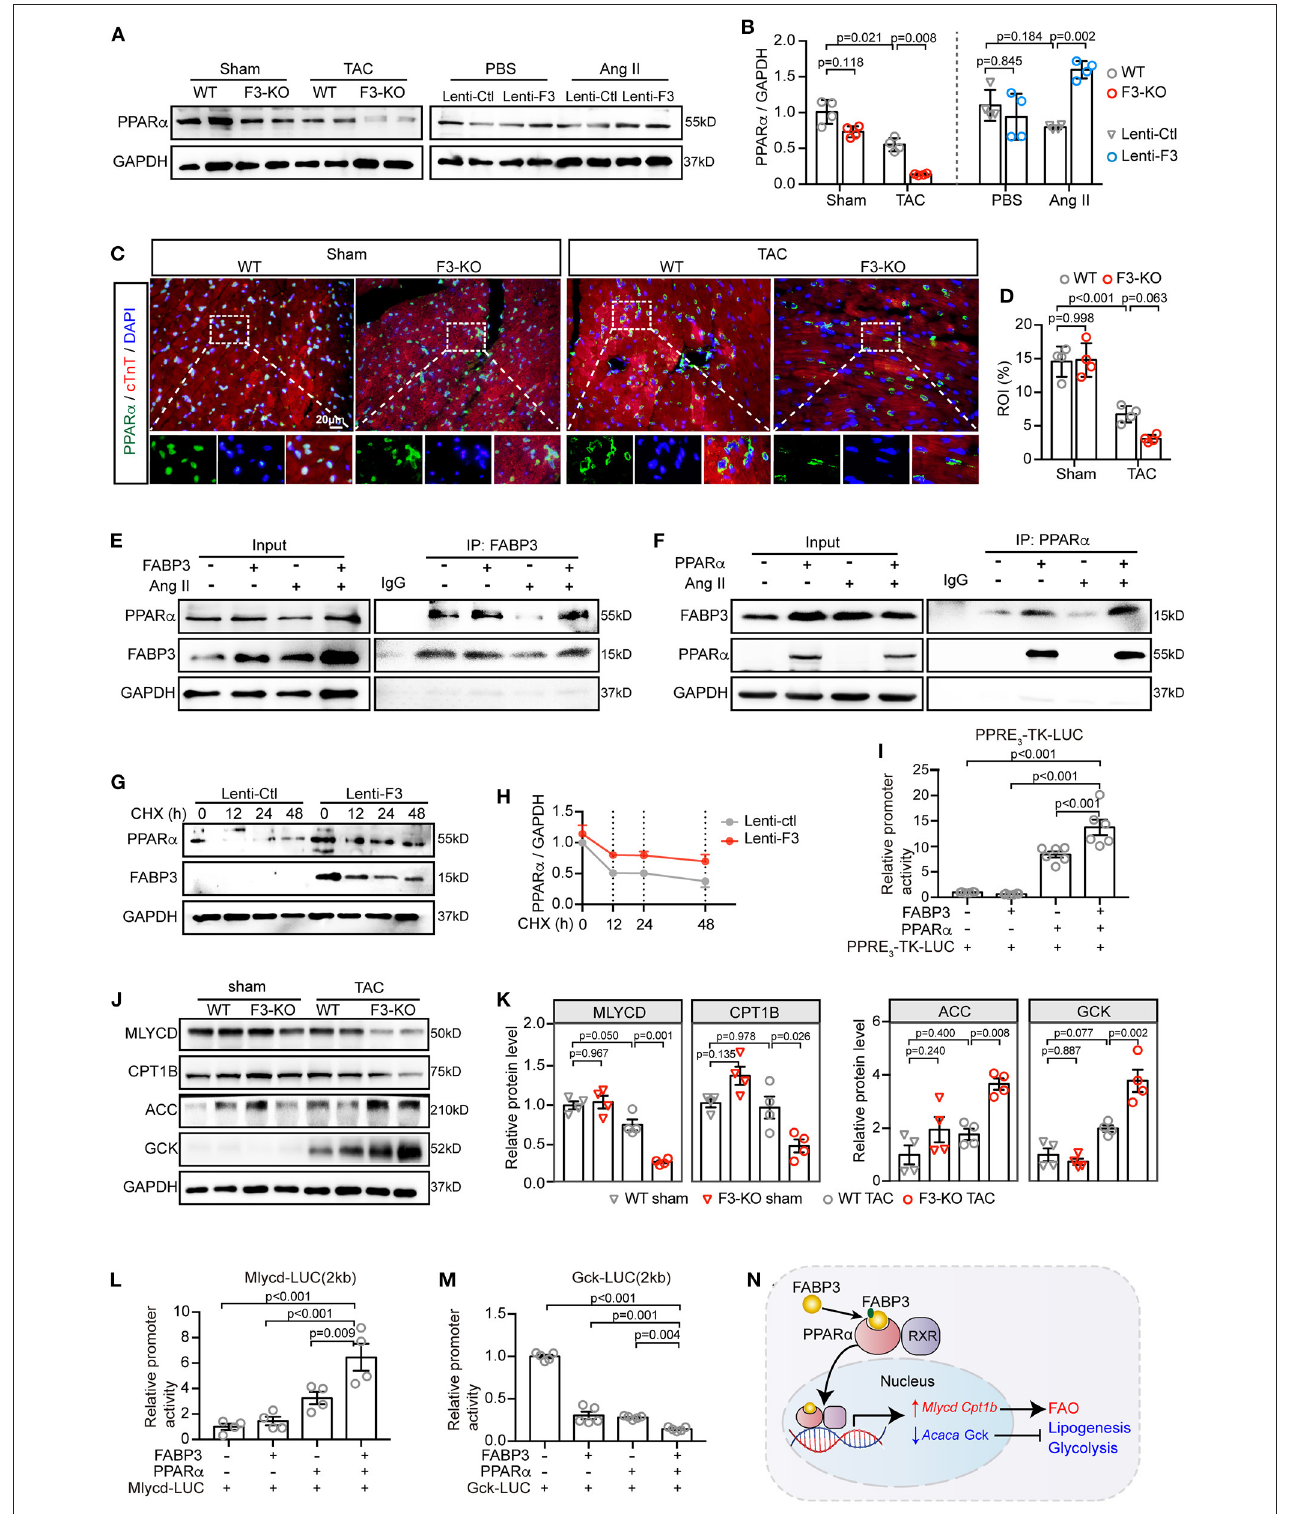
FIGURE 6 | FABP3 mediates metabolic reprogramming by directly interacting with PPAR α , preventing its degradation and enhancing its transactivation. (A) Representative western blot images of PPAR α from TAC-operated WT and F3-KO hearts, or from NRVMs transfected with Fabp3 or its control virus with or